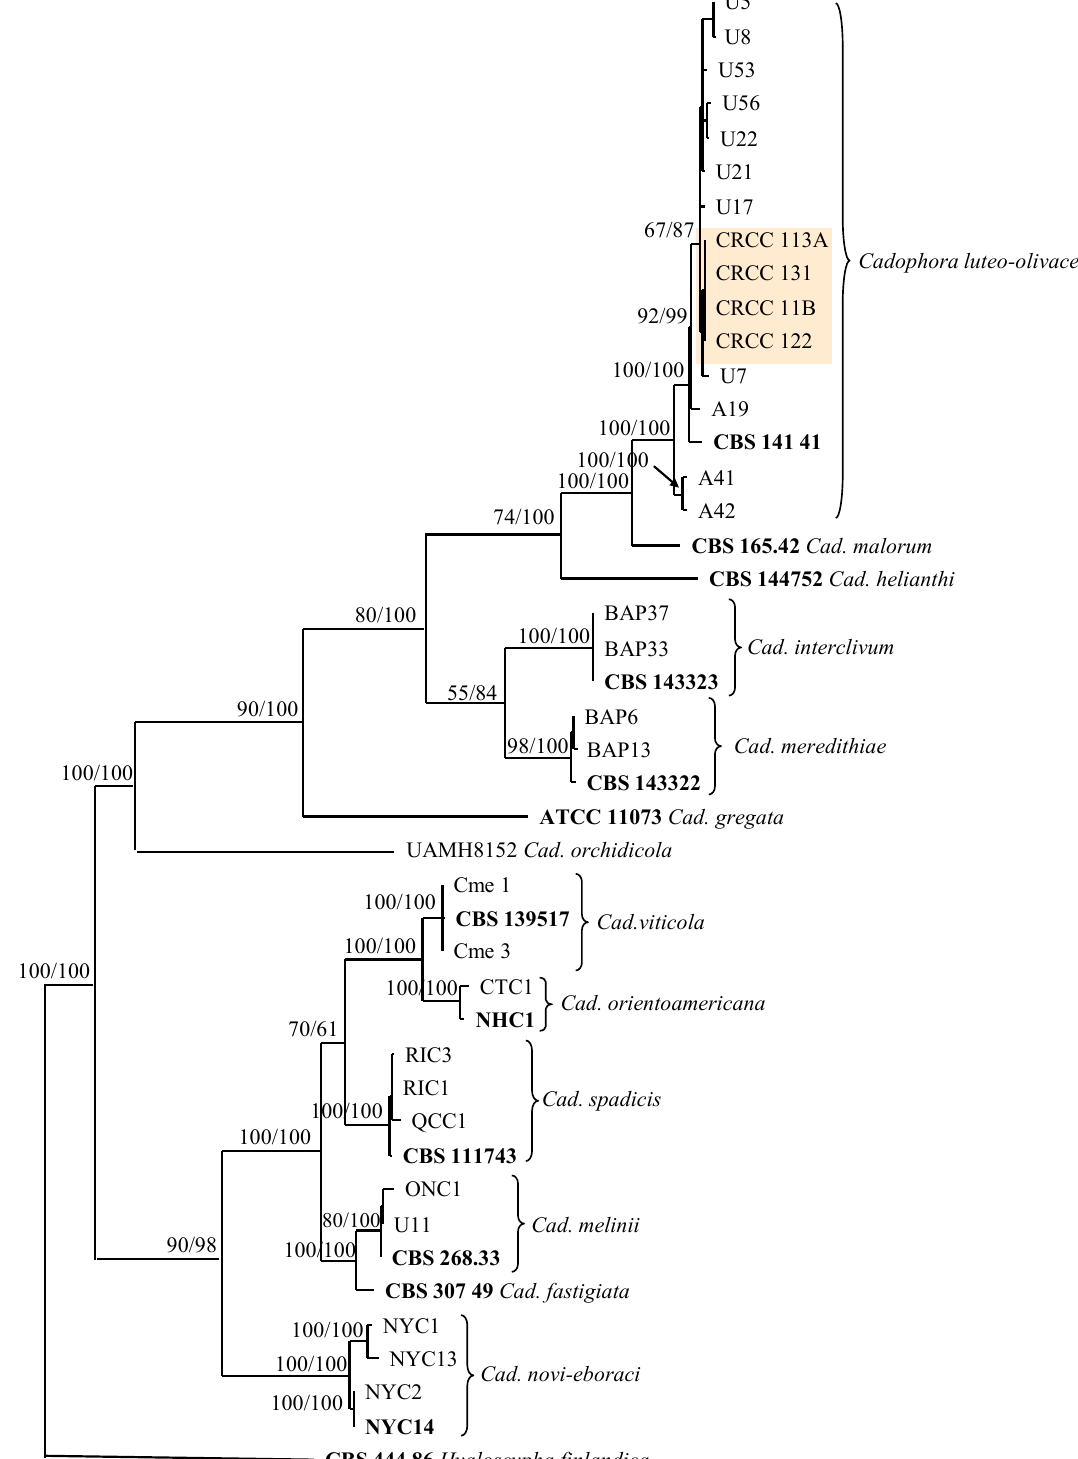
Figure 4. One of the most parsimonious trees obtained from combined ITS, tef-1 α and tub sequence datasets of Cadophora isolates, with bootstrap support values from maximum parsimony/maximum likelihood analyses. Isolates obtained in this study are indicated by an orange rectangle. Ex-type sequences are indicated in bold. Hyaloscypha finlandica was used as